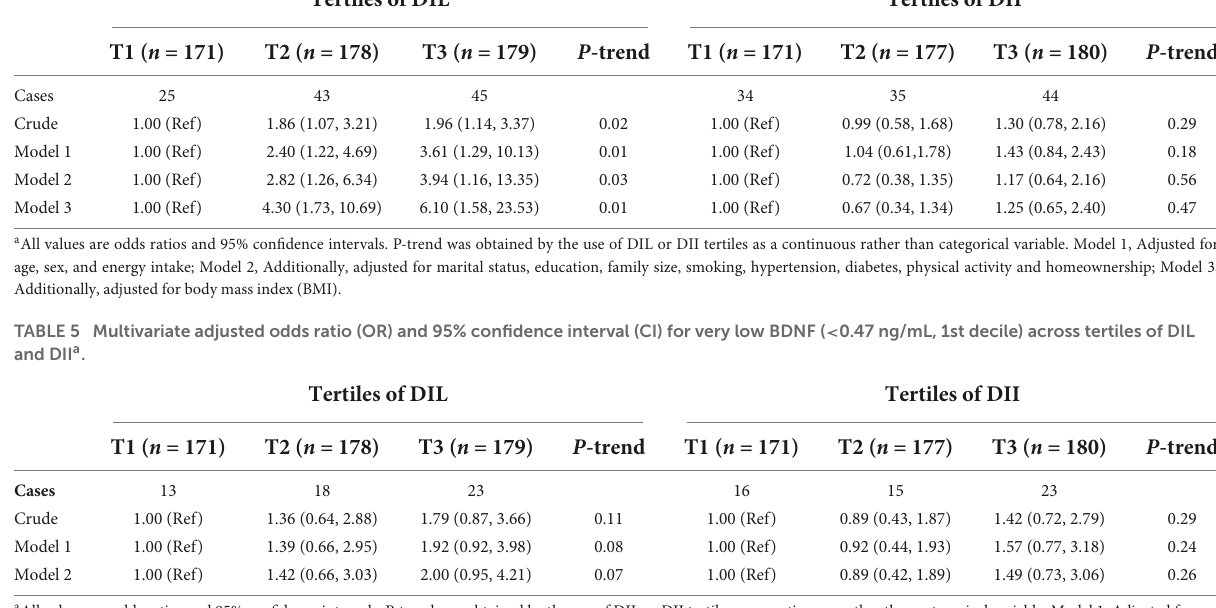
TABLE 4 Multivariate adjusted odds ratio (OR) and 95% confidence interval (CI) for HTGW phenotype across tertiles of DIL and DII a . Tertiles of DIL Tertiles of DII